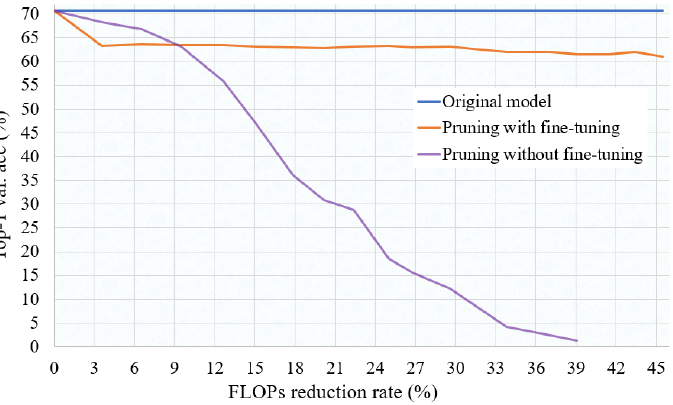
Figure 2. Validation accuracy across training epochs while baseline training and fine-tuning the pruned ResNet-18 model on the ImageNet dataset.